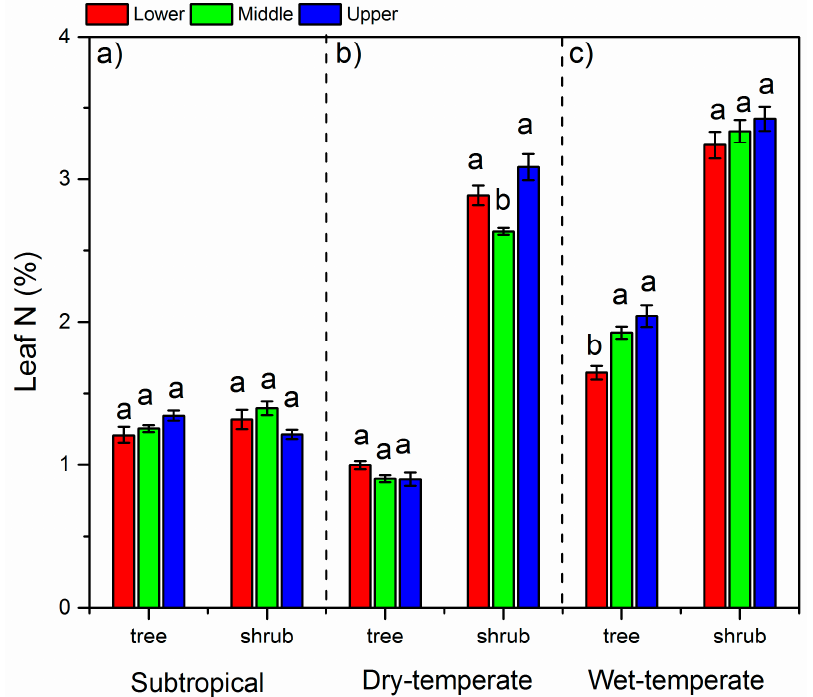
Figure 3. Leaf N of trees and shrubs along the altitude in subtropical ( a ), dry-temperate ( b ) and wet-temperate mountain forest ( c ), different lower case letters indicate the difference for leaf N concentration between altitudes.